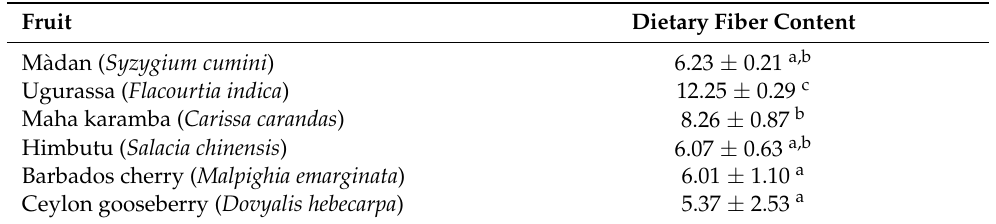
Table 2. Total dietary fiber content (% of fresh).